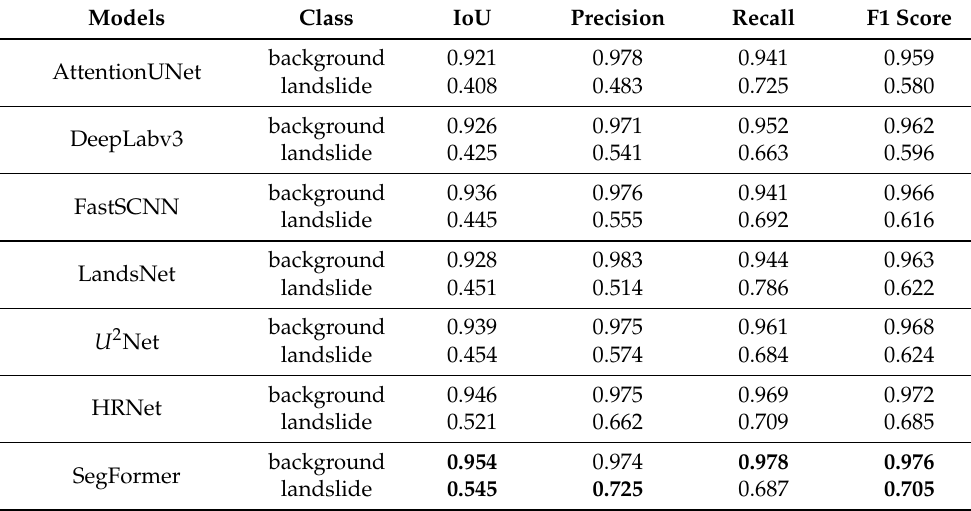
Table 2. Comparison of segmentation accuracy for each class (landslide and